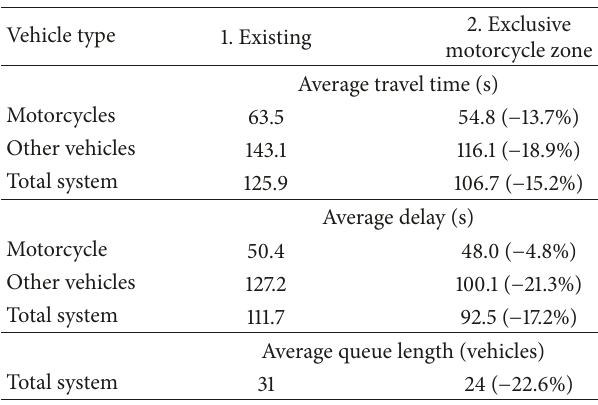
Table 6: Results of the effectiveness of traffic flow measures. Vehicle type